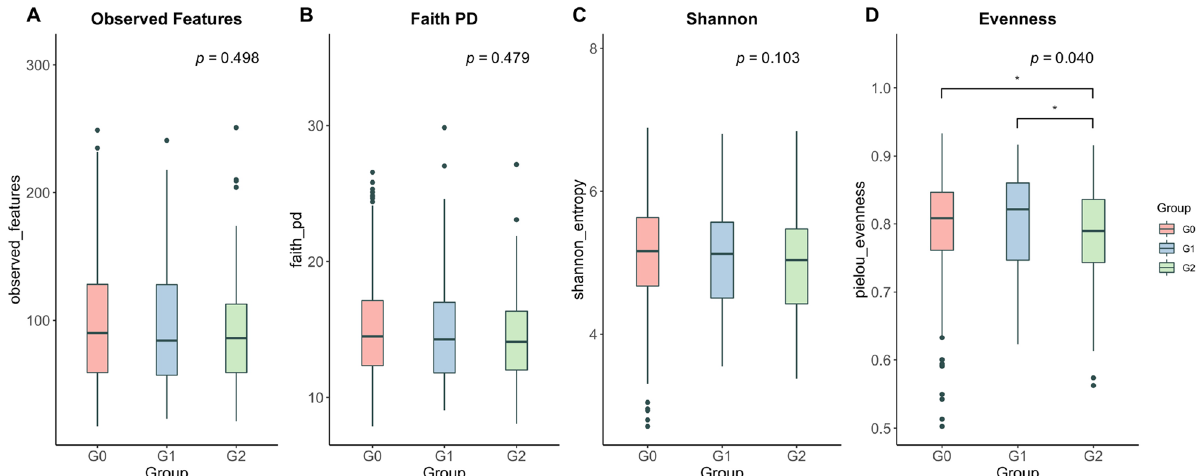
Figure 2. Alpha diversity of the microbiota among the renal stone groups. Boxplots representing alpha diversity include the observed features ( A ), Faith’s phylogenetic diversity ( B ), Shannon’s index ( C ), and Pielou’s evenness ( D ) of the three groups. Statistics were calculated using a pairwise Kruskal–Wallis test among the three groups. The p -values were corrected using the Benjamini–Hochberg false discovery rate (FDR) (* p < 0.05). Boxes indicate the interquartile range (IQR) of the 25th to 75th percentiles. The median value is shown as a line within the box, and the whiskers extend to the most extreme value within 1.5 × IQR. Possible outliers are shown as dots. G0: no renal stones (control); G1: incidental renal stones; and G2: prevalent renal